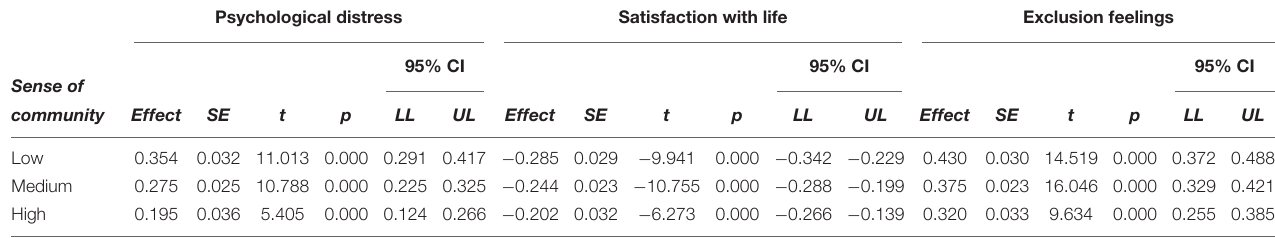
TABLE 4 | Conditional effect of Perceived discrimination on psychosocial well-being variables at values of the Sense of community. Psychological distress